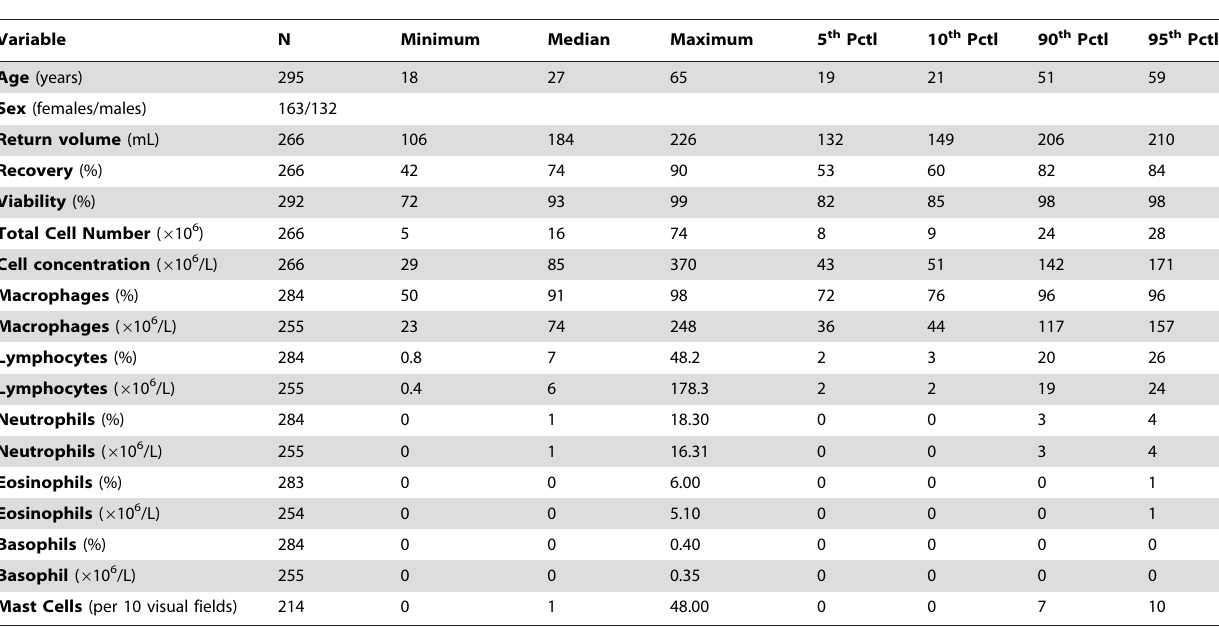
Table 2. Descriptive statistics of bronchoalveolar lavage fluid findings in healthy never-smoking subjects.